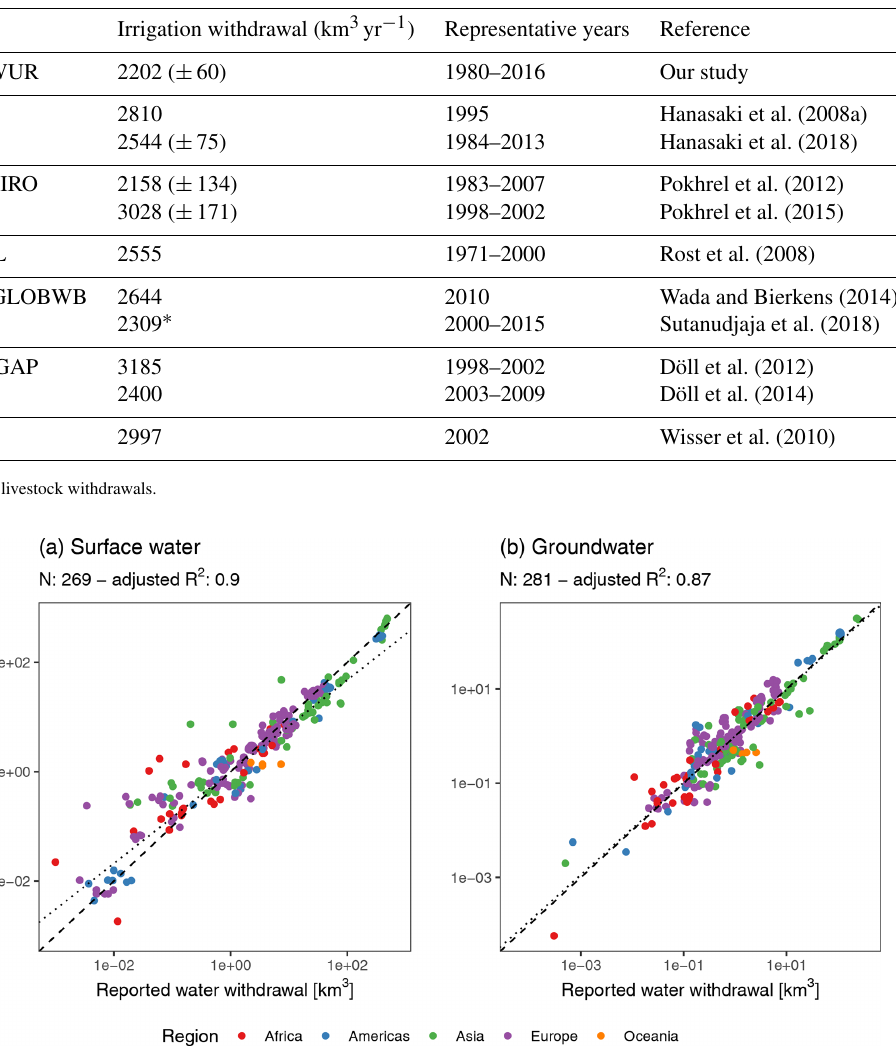
Figure 4. Comparison between simulated national annual water withdrawals and FAO-reported values from (a) surface water and (b) ground- water. Colours distinguish between regions. The dashed line indicates the 1 : 1 ratio, and the dotted line indicates the simulated best linear fit. Note the log–log axis which is used to display the wide range of water withdrawals. The adjusted R 2 is also based on the log